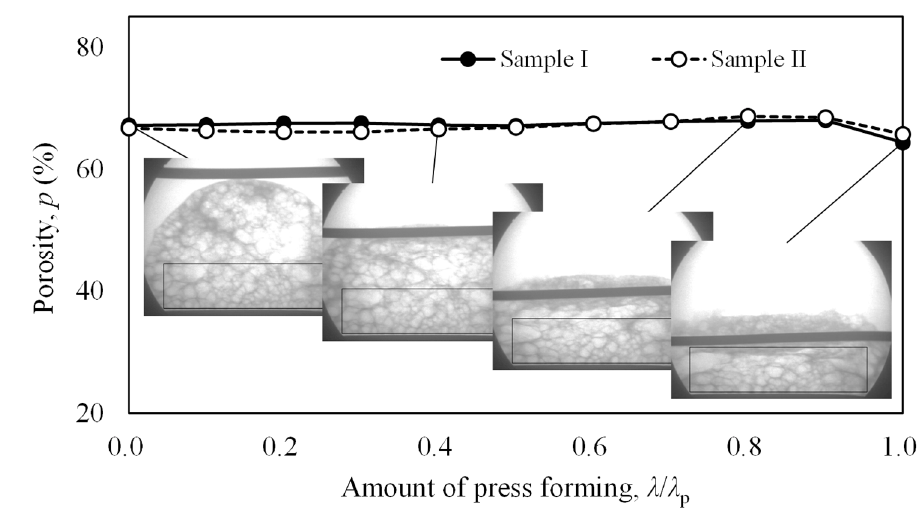
Figure 6. ( a ) Sample I and ( b ) its cross-sectional X-ray CT image in thickness direction. ( c ) Sample II and ( d ) its cross-sectional X-ray CT image in thickness direction.